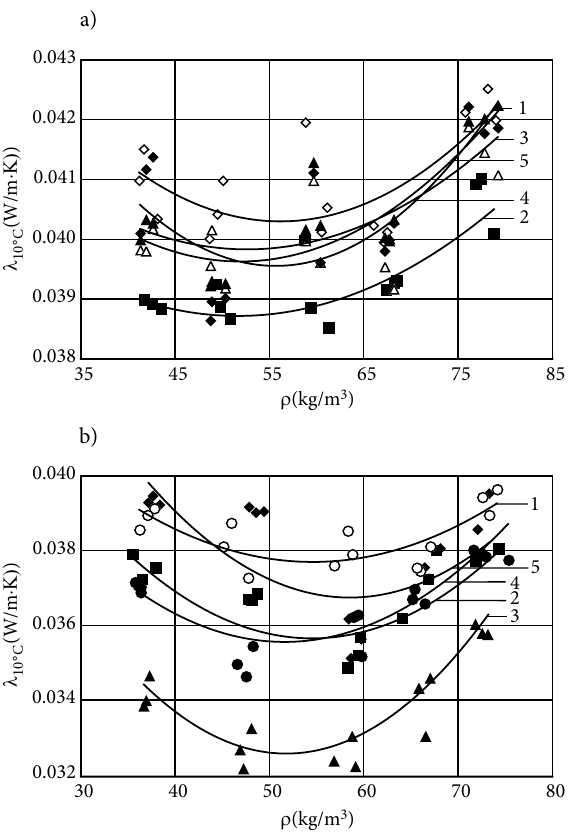
Fig. 8. The dependence of the thermal conductivity of mechan- ically processed straw on graphite content: a) chopped straw when graphite content by mass makes 1 – 3%, 2 – 5%, 3 – 7%, Fig. 7. View of defibered straw: a) a general view of straw fibre 4 – 10%, 5 – 20%, b) defibered straw when graphite content by (200×), b) the inside part of straw stalk (1 000×), c) an outer mass makes 1 – 3%, 2 – 5%, 3 – 7%, 4 – 10%, 5 – part of straw stalk (3